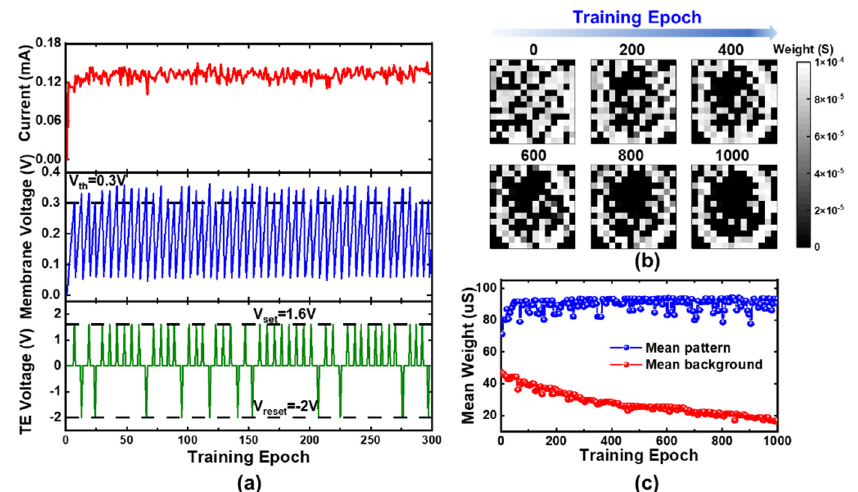
Figure 4. Hardware demonstration of the learning process for digit “0”. ( a ) Evolution of integral current (top), membrane voltage (middle) and the top electrode voltage (bottom); ( b ) Change process of the synapse weights; ( c ) Evolution of the mean weights in pattern (blue) and background (red) pixels.